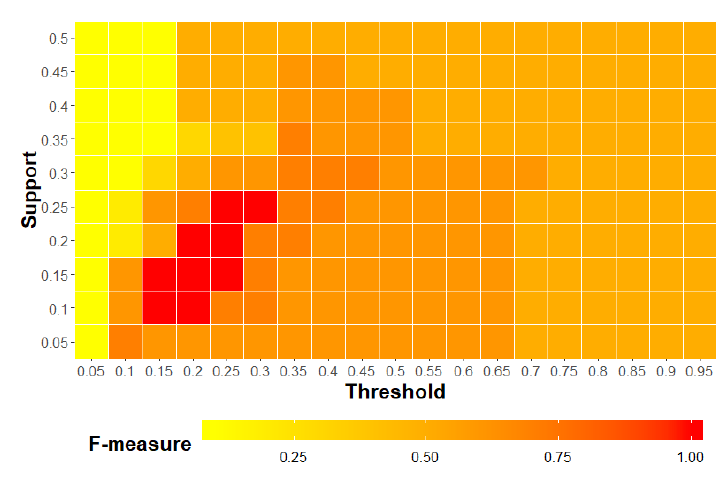
Figure 7. F-measure with different support and threshold for user anomaly behavior detection.